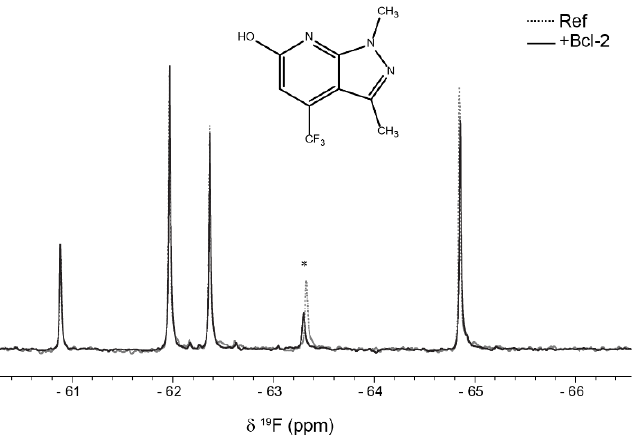
Figure 5. Zoomed region of 19 F 100ms spin-echo spectra showing signals from five fragments (100 mM) in absence (dashed line) and presence (solid line) of 10 mM Bcl-2. Decreased signal intensity is observed for the peak marked with asterisk, identified as the fragment structure in the figure.